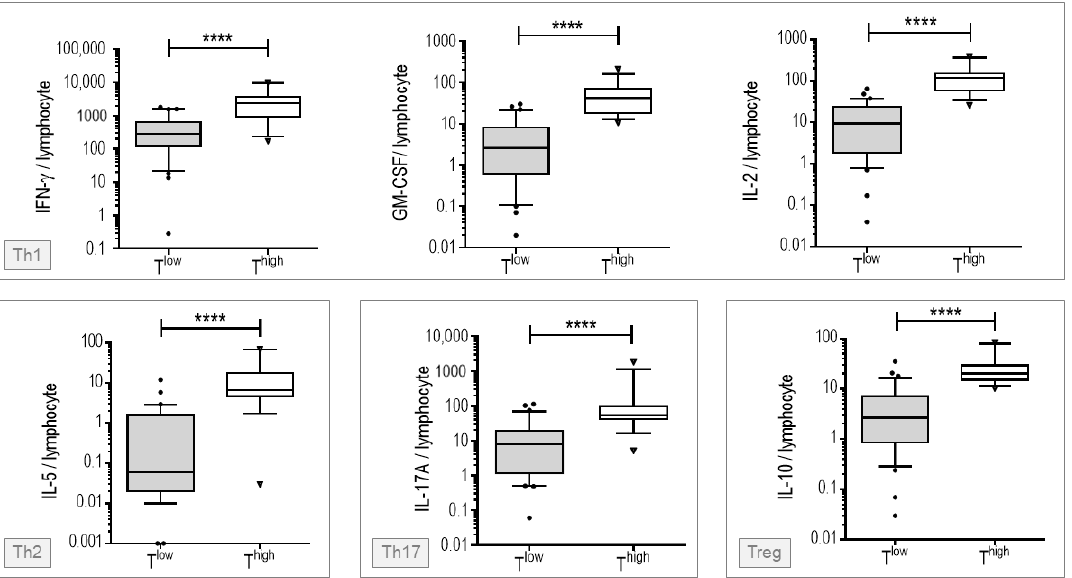
Figure 2. Cytokine levels secreted by blood cells of low and high T cell responders. Blood cells were stimulated at 37 ◦ C for 25 h with anti-CD3/CD28 agonist mAbs in an integrated collection and cell culture system. IL-2, IL-5, IL-10, IL-17A, IFN- γ and GM-GSF levels were measured in cellular supernatants. The ratio between the levels of cytokines and the number of blood lympho- cytes was computed. Statistical significance of differences between groups was assessed using the Mann–Whitney non-parametric test. T high , high T cell responders; T low , low T cell responders. ****, p < 0.0001.